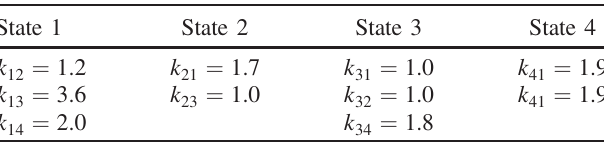
TABLE I. Transition rates for the unicyclic network in Fig.